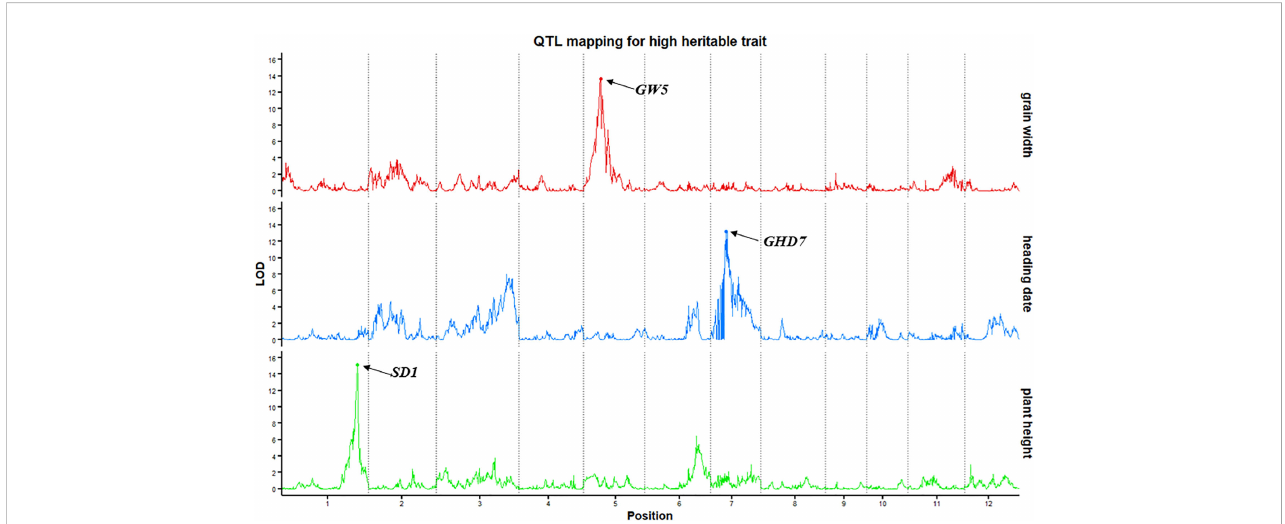
FIGURE 2 QTL mapping for highly heritable traits (plant height, heading date and grain width). The x-axis scales genetic distance on chromosomes, while the y-axis represents the LOD scores of each trait.